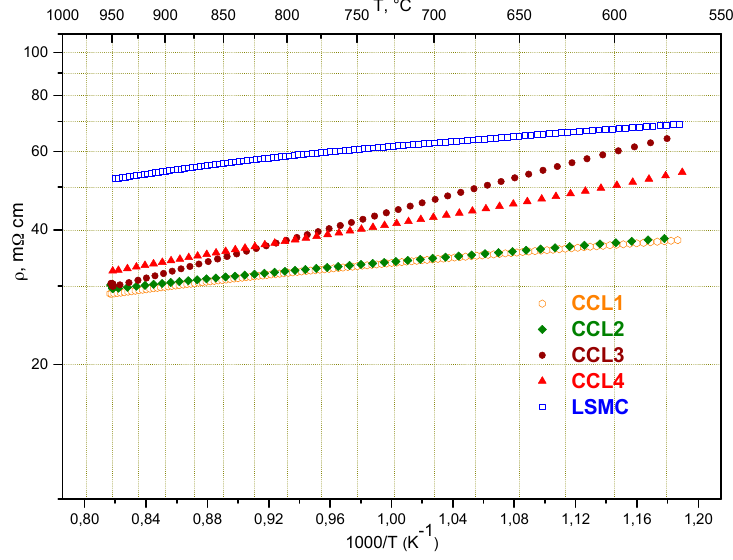
Figure 7. Resistance of different CCL layers in dependence of temperature.